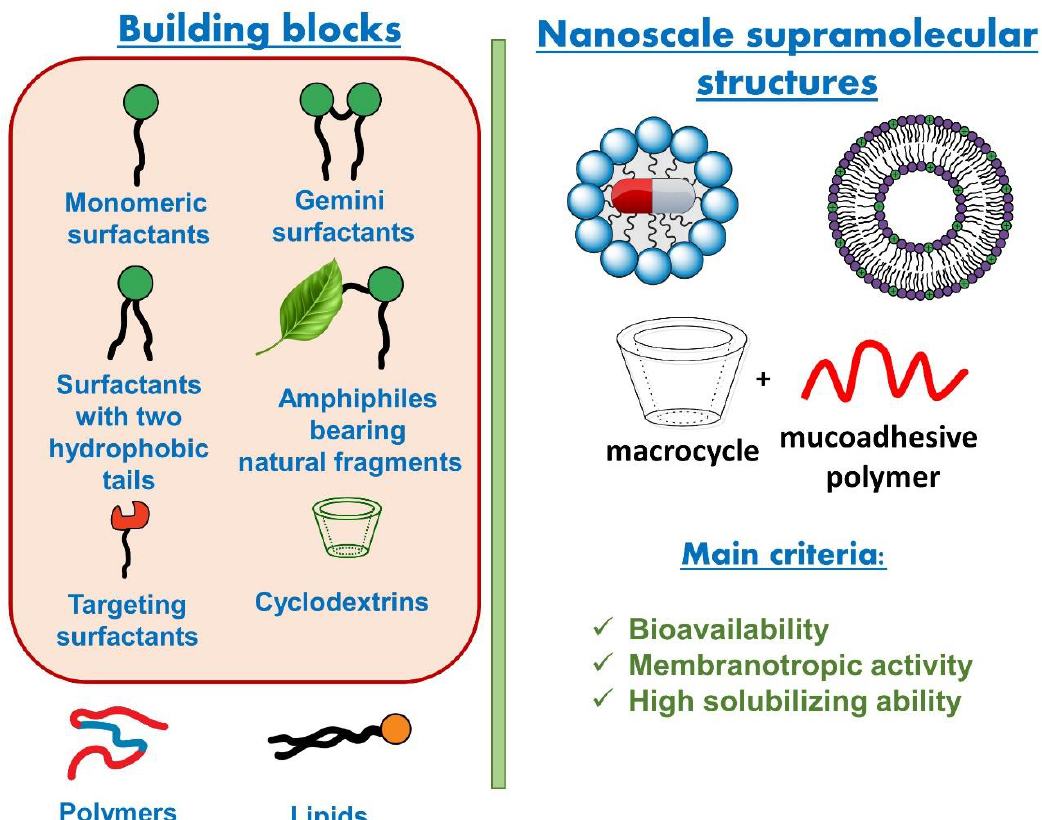
Figure 9. Schematic illustration of the building blocks and diversity of obtainable nanocarriers using non-covalent bilayer modification.